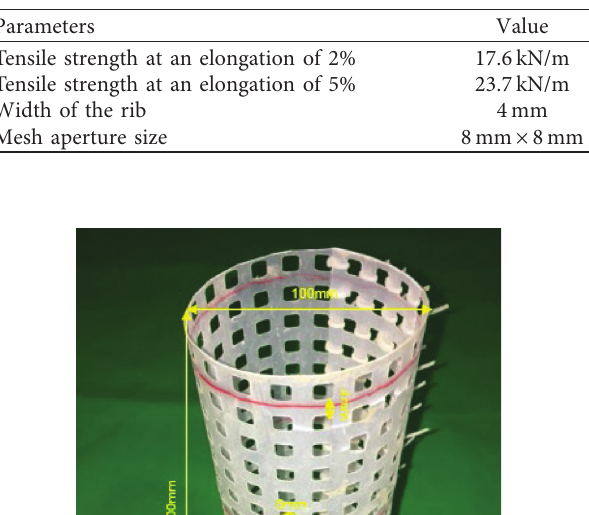
Table 1: Properties of the biaxial geogrid.